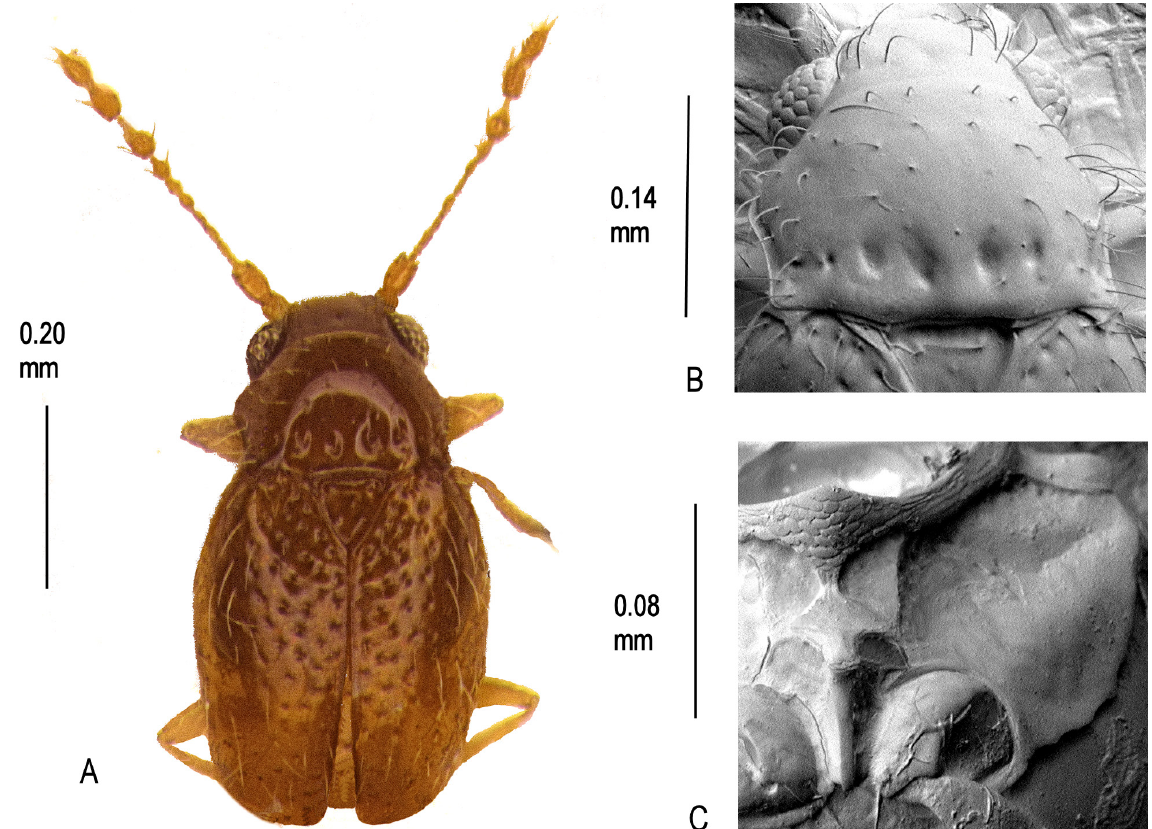
Fig. 45 . Cissidium yoruba sp. nov. A . Habitus. B . Pronotum, × 640. C . Mesoventrite showing median process of collar, mid-keel, keel and lateral margin,